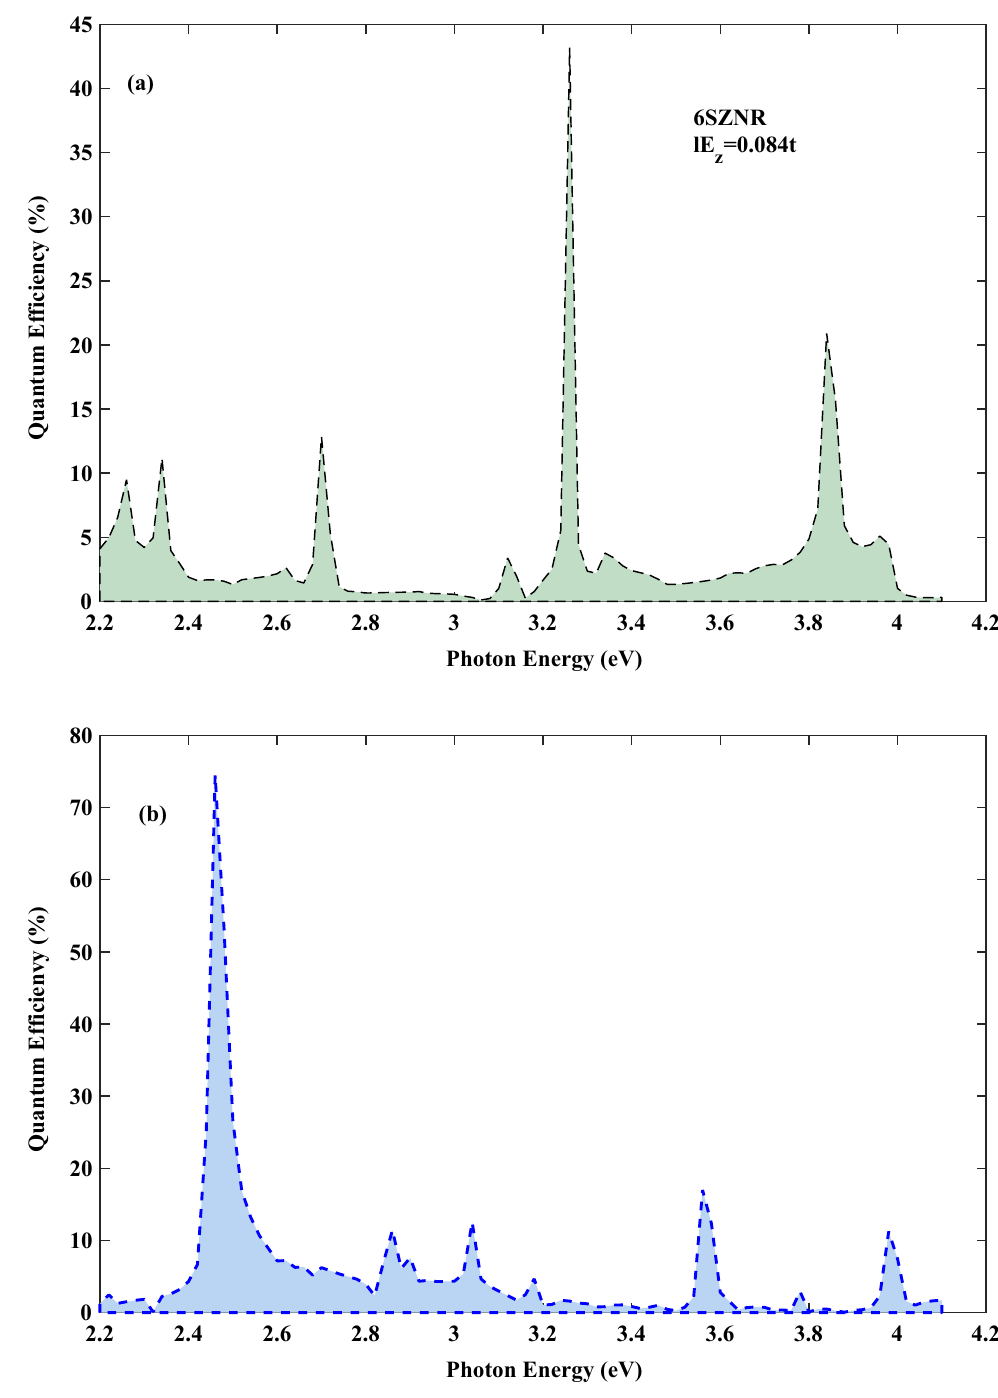
Figure 4. Quanmtum efficiency as a function of the photon under the simultaneous effect of linear illumination 100 kW with I w cm 2 ( a ) for the spin-photovoltaic device based on 6 SZNR with = photovoltaic device based on 10 SZNR with elE z